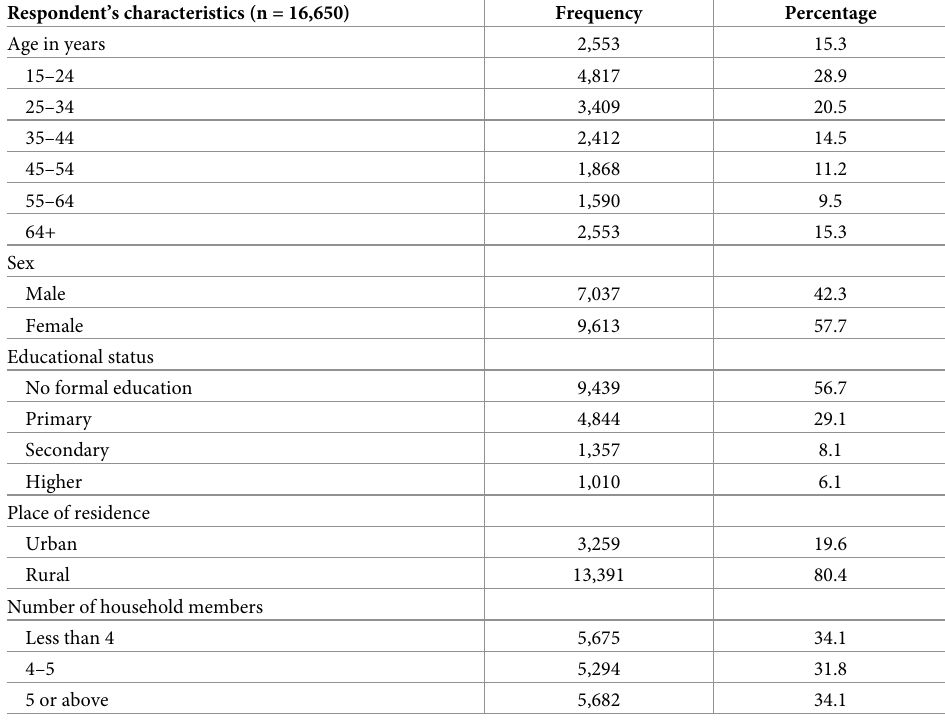
Table 1. Socio-demographic characteristics of the respondents, Ethiopian Demographic and Health Survey,